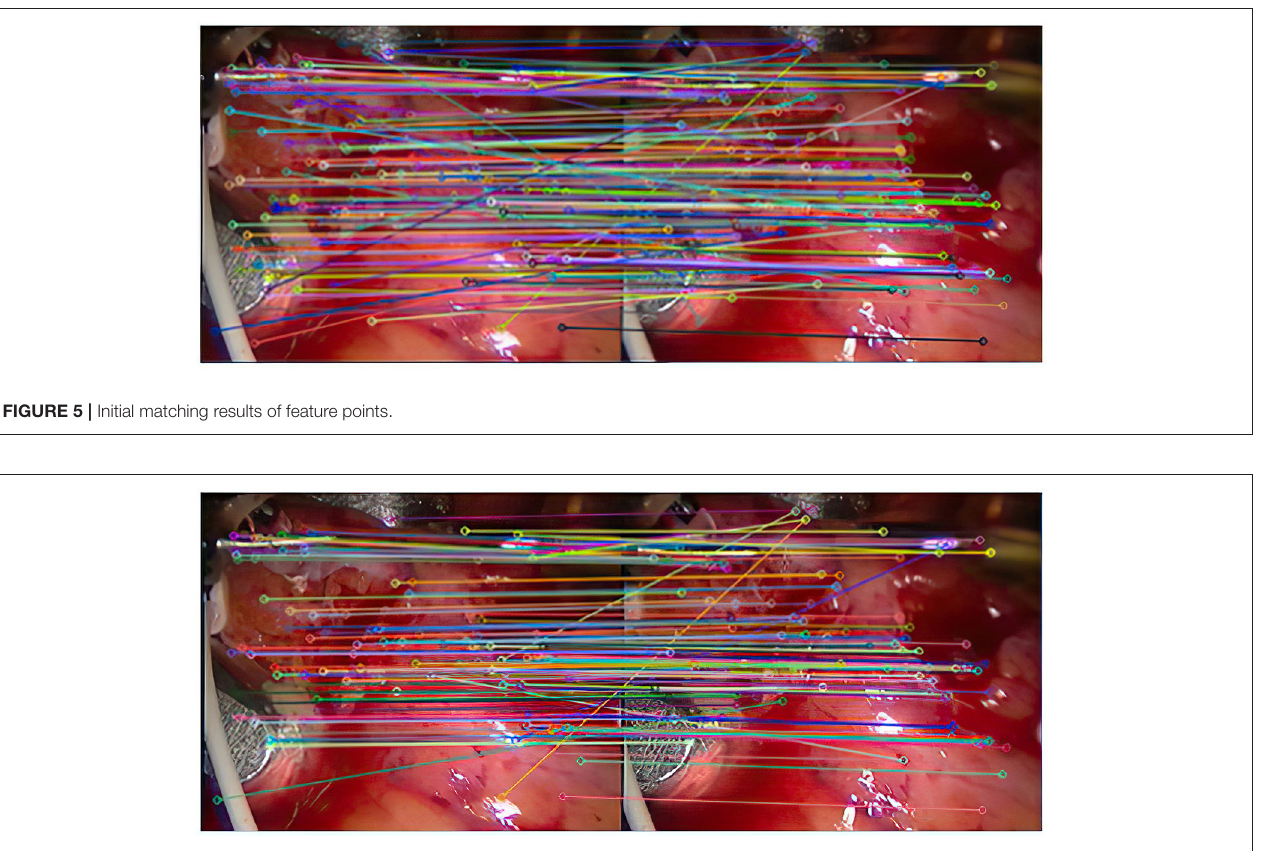
FIGURE 6 | Result of RANSAC after removing